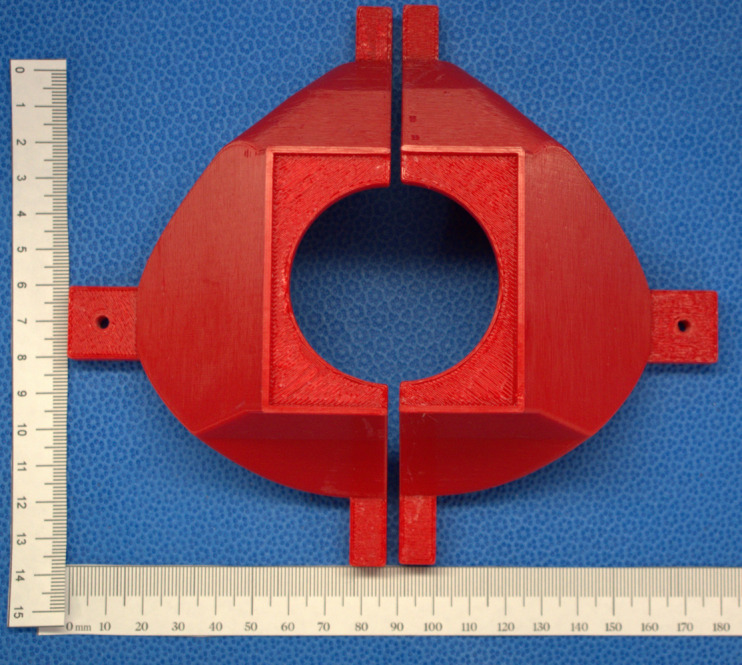
3D printed mold top cover left and right halves with a pour hole for silicone is shown.